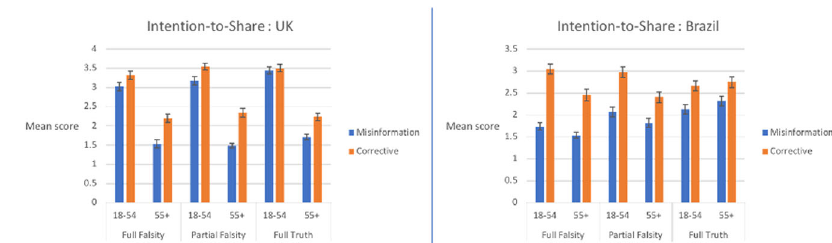
Fig. 5 Intention-to-share. Mean intention-to-share scores across misinformation type and exposures in the UK and Brazil.